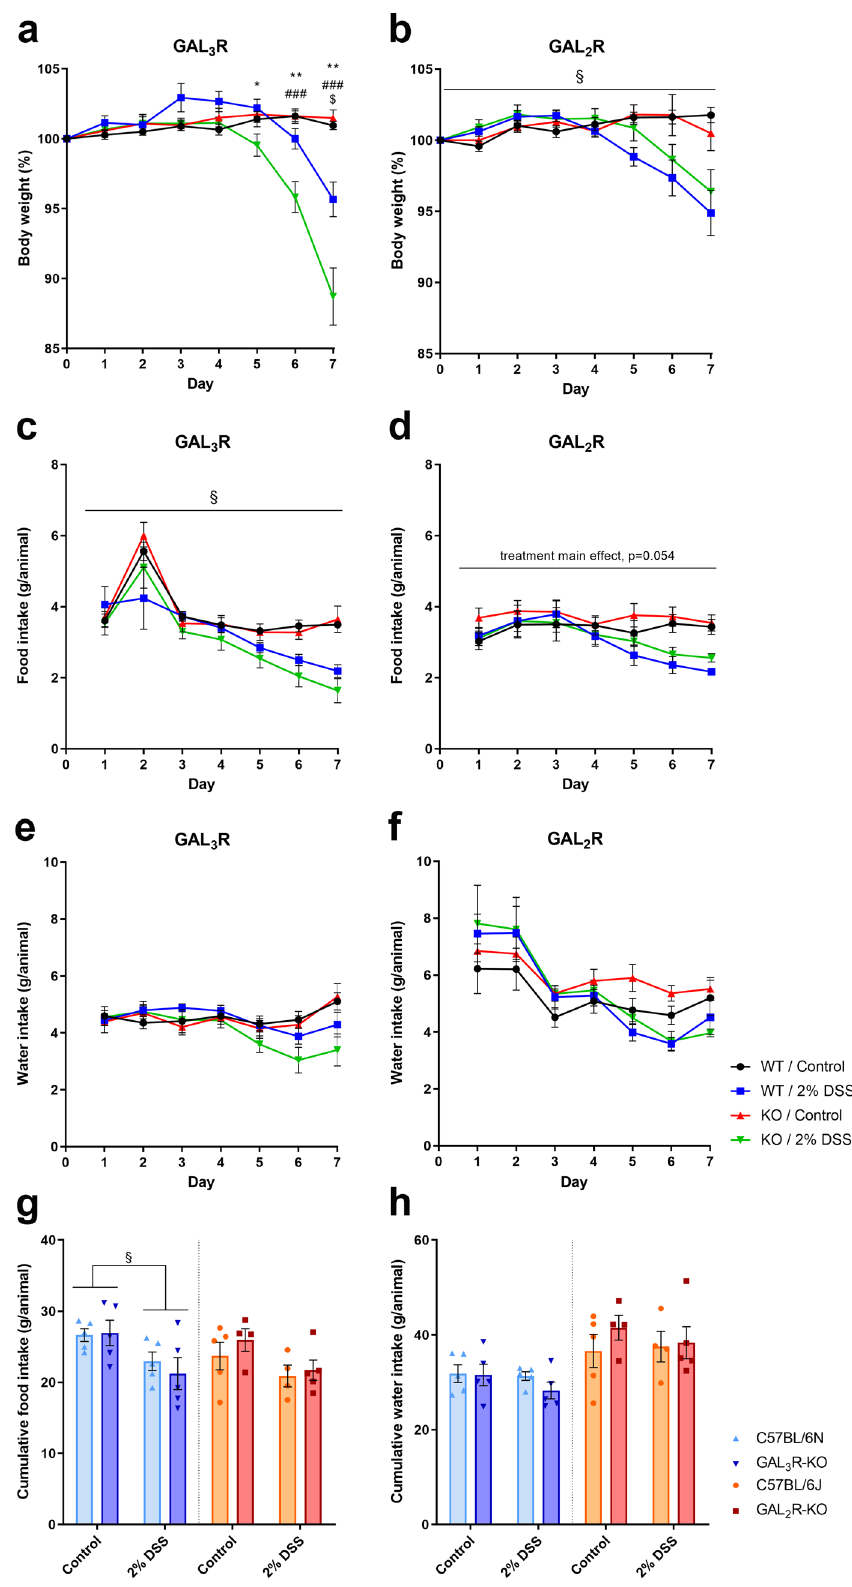
Figure 2. Body weight (% to starting weight) ( a , b ), food ( c , d ) and water intake ( e , f ) following colitis induction, as well as cumulative food ( g ) and water intake ( h ) in GAL 3 R-KO ( a , c , e , g , h ), GAL 2 R-KO ( b , d , f , g , h ) and corresponding WT mice. Data represent means ± SEM. n = 9–11. Data were analyzed by two-way RM or two- way ANOVA followed by appropriate post hoc tests. Main effect treatment, § p < 0.05; WT/Ctl versus WT/DSS, $ p < 0.05; KO/Ctl versus KO/DSS, ### p < 0.001; WT/DSS versus KO/DSS, * p < 0.05; ** p <